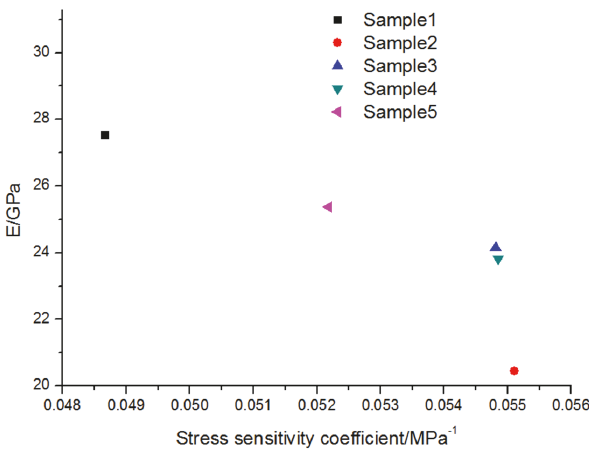
Figure 5: Elastic modulus versus stress sensitivity